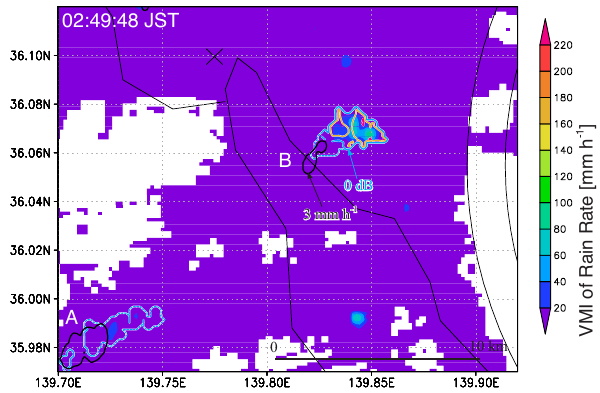
Figure 11. The horizontal distribution of VMI( Z DR ) and the surface rainfall rate superimposed over VMI( R ), estimated from the MRI C-band polarimetric radar at 02:53 JST. Thick black contours indicate surface rainfall rates of 3 mm h -1 and 18 mm h -1 . Solid colored contours indicate VMI( Z DR ) at altitudes above the freezing level from 0 dB with a contour interval of 3 dB (blue, orange, and red represent 0 dB, 3 dB, and 6 dB, respectively), and dashed-blue contours depict VMI( Z DR ) located at altitudes lower than the freezing level at 0 dB. A blue rectangle indicates the analytical area in Figs. 12-14.